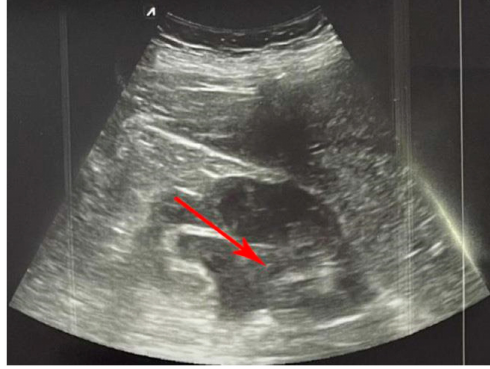
Figure 4. Severe hydronephrosis (left kidney) (red